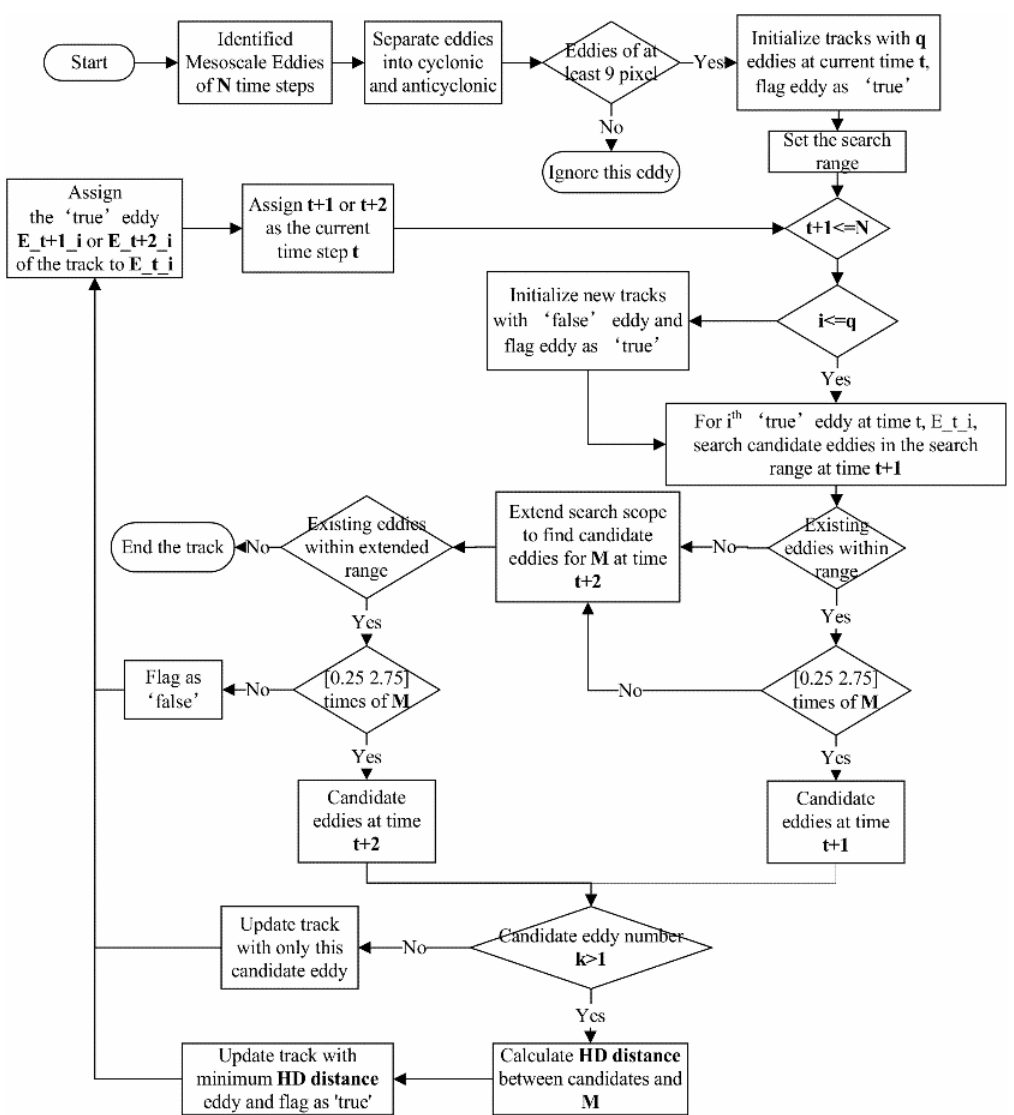
Figure 2. Hybrid algorithm workflow.